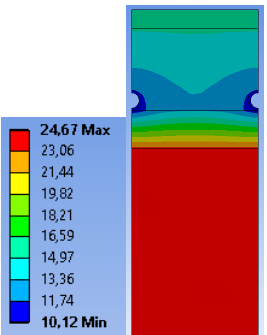
Figure 1. Temperature distribution in a floor cooling system (air temperature 26 °C,